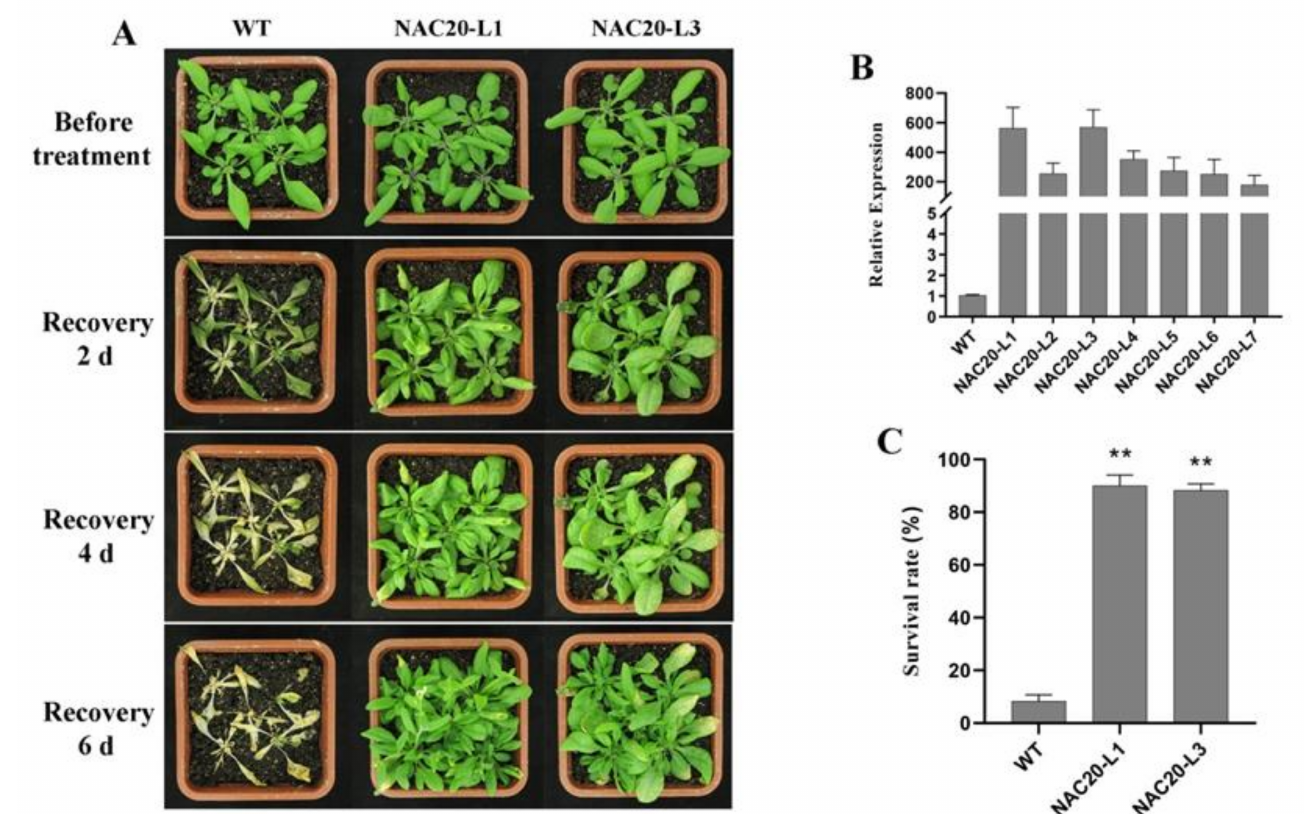
Figure 8. Overexpression of HuNAC20 in Arabidopsis enhanced freezing tolerance. ( A ) Performance and ( C ) survival rates of WT and HuNAC20 transgenic plants after freezing; ( B ) expression levels of HuNAC20 in WT and transgenic plants. AtACTIN2 was used as an internal control. Twenty seedlings per transgenic line were used in each freezing treatment. Data represent average values from three biological replicates ( ± S.D.). Asterisks indicate significant differences (** p < 0.01) between the transgenic lines and WT